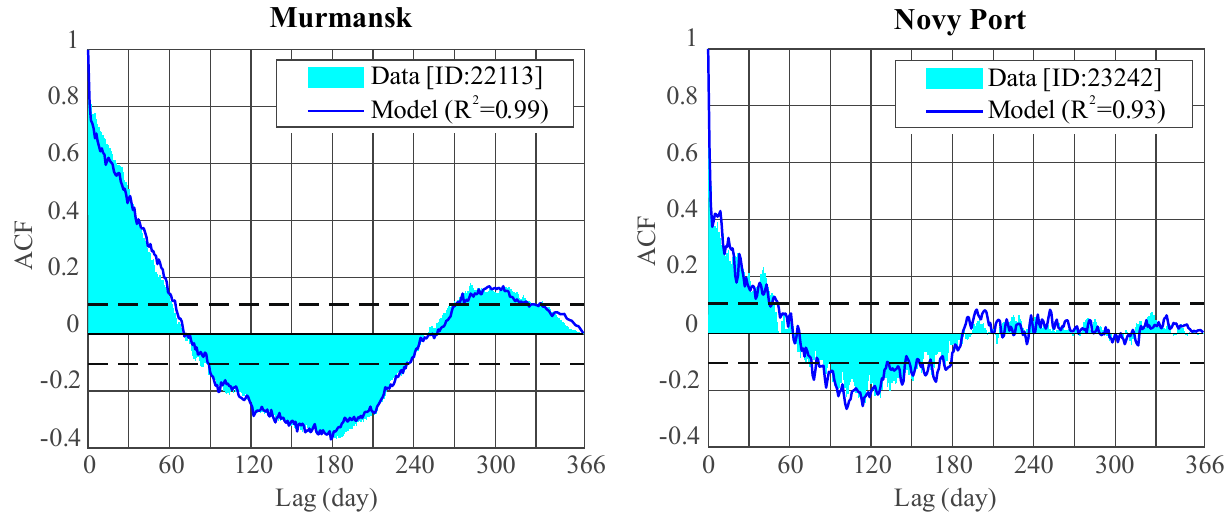
Figure 9. Daily average wind speed autocorrelation. The histograms of the real distribution of wind speed approximated by the Weibull distribution are shown in Figure 10 and are compared with the distribution of the simulated data. It can be seen that the probability distribution of the simulated data, as well as the analytical Weibull PDF, are quite accurately fit to the histograms of the actual distribution.